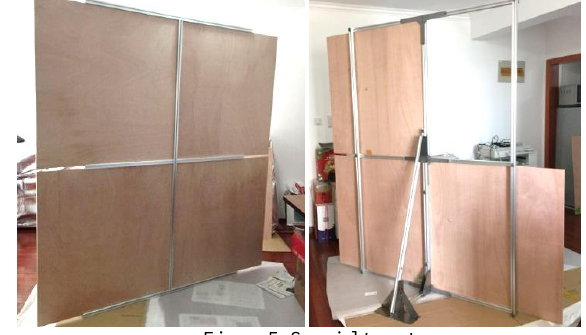
Figure 5. Special target